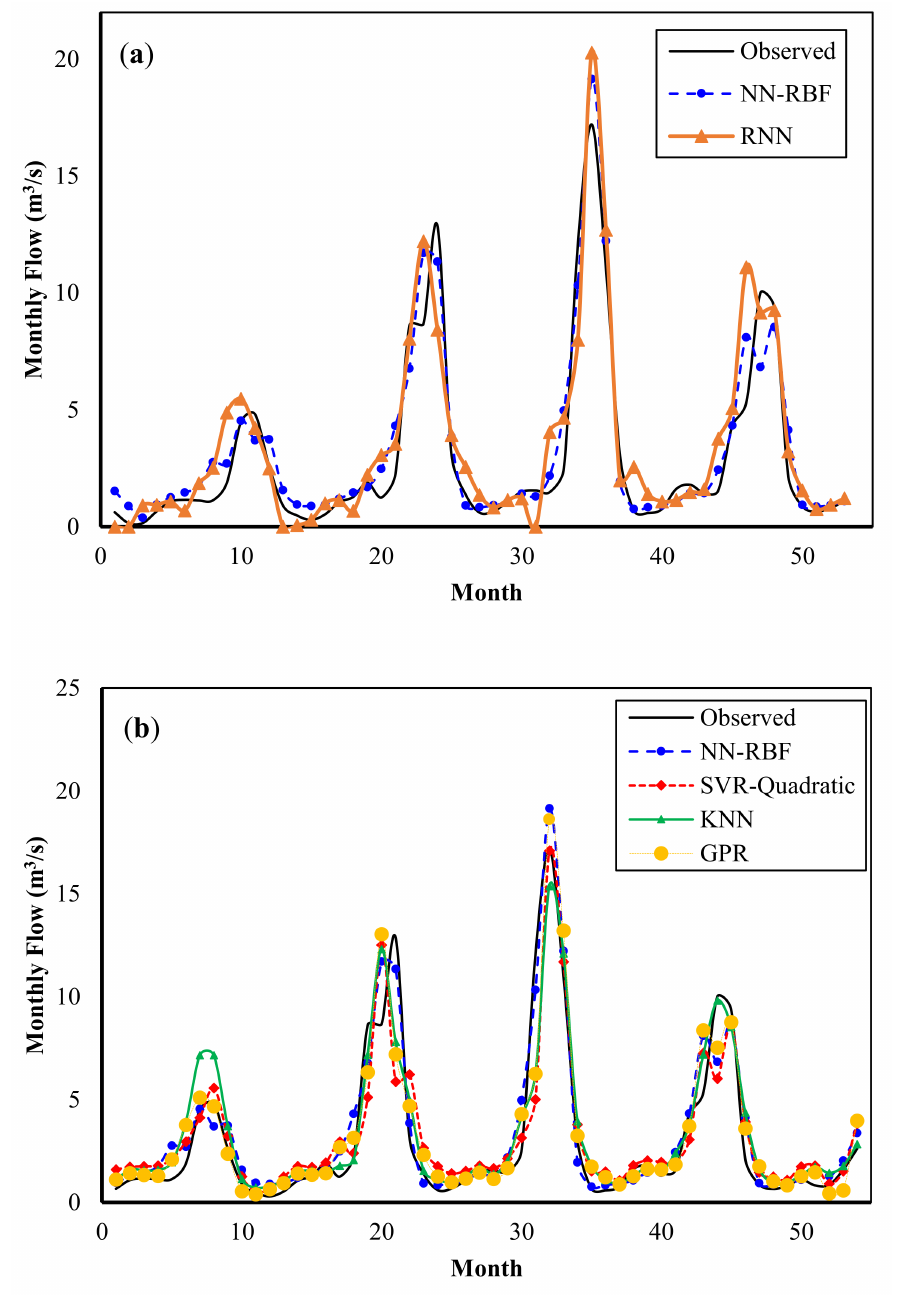
Figure 8. Monthly flow prediction for verification dataset for Alavian Basin: ( a ) NNRBF and RNN, and ( b ) NNRBF, SVR-Quadratic, KNN, and